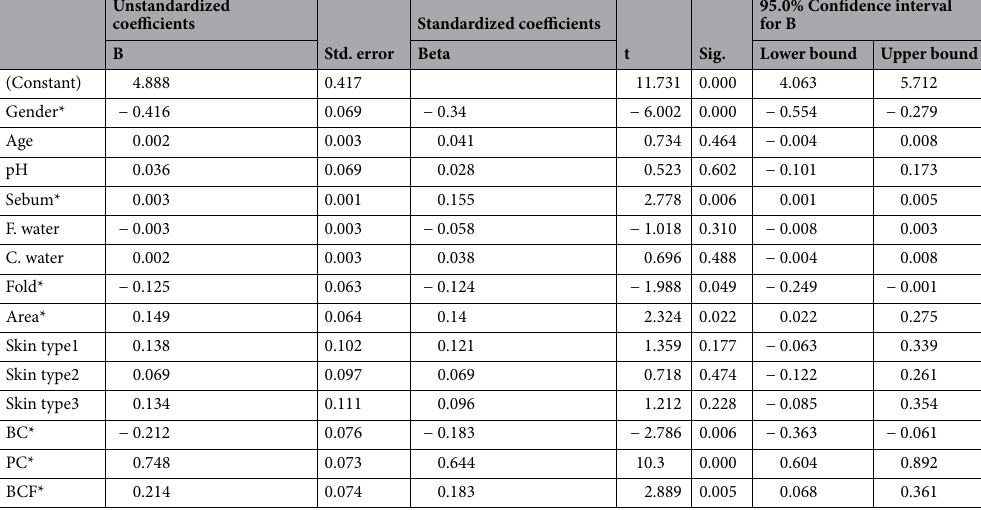
Table 3. Coefficients of the variables in the linear regression model and their corresponding hypothesis test results. BC binchotan charcoal fiber, PC plant cellulose, BCF bamboo charcoal fiber. * P <